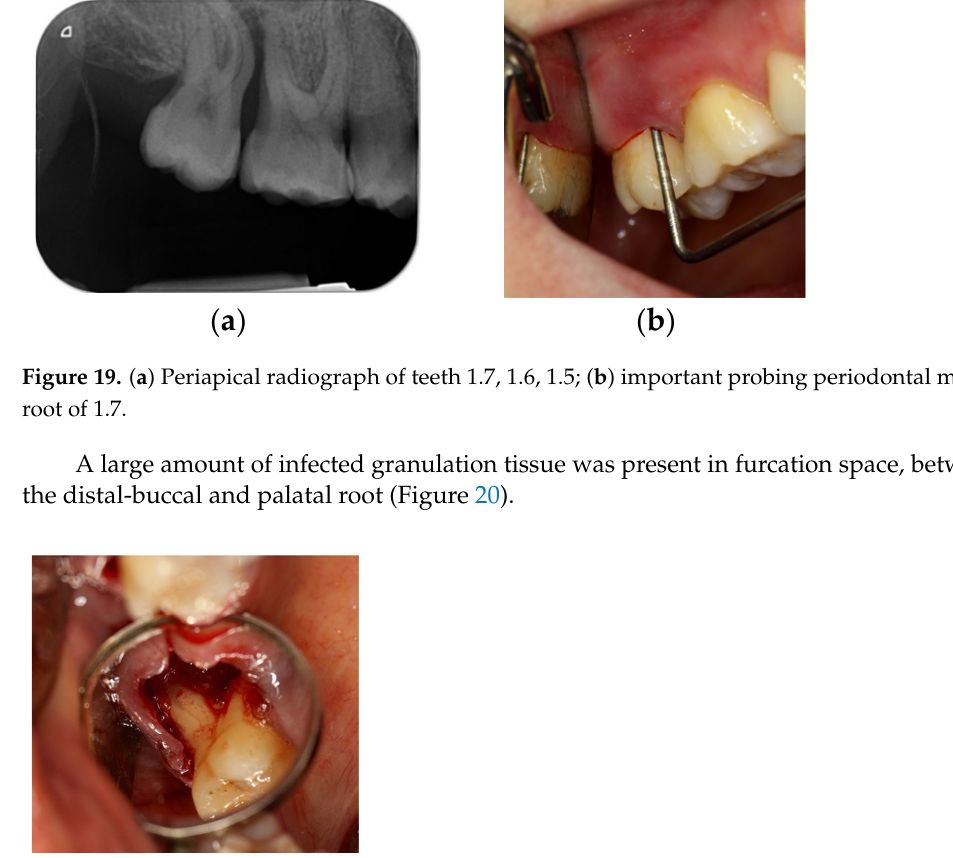
Figure 18. prosthetic finalization of the case and mucose quality. Figure 18. Prosthetic finalization of the case and mucose quality. In this case of chronic periodontal abscess between teeth 1.7 and 1.6, there was an important buccal and palatal periodontal pocket of 9 mm with a large resorption of the interdental bone septum. It was decided to extract the tooth 1.7 because of its poor prognosis (Figure 19a,b).